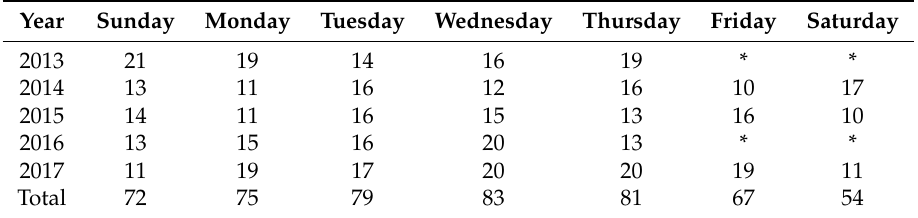
Table 12. Number of suicides among the Dutch population under 23 for each day of the week over the period 2013–2017.